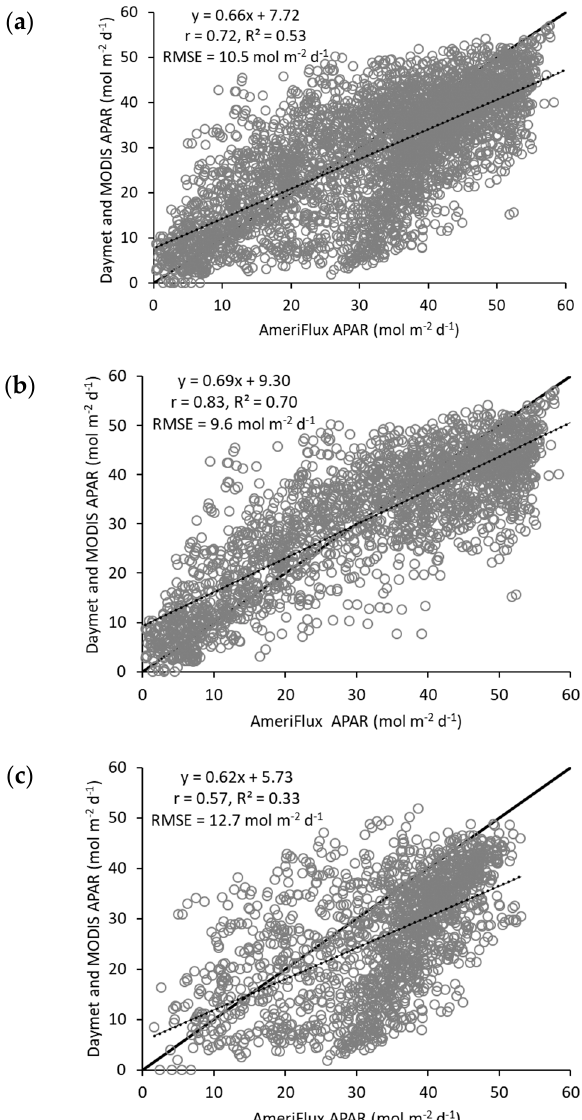
Figure 9. AmeriFlux measured APAR as a function of Daymet and MODIS derived APAR for all three Nebraska sites for ( a ) all growing season days, ( b ) all green-up days, ( c ) all post green peak days.